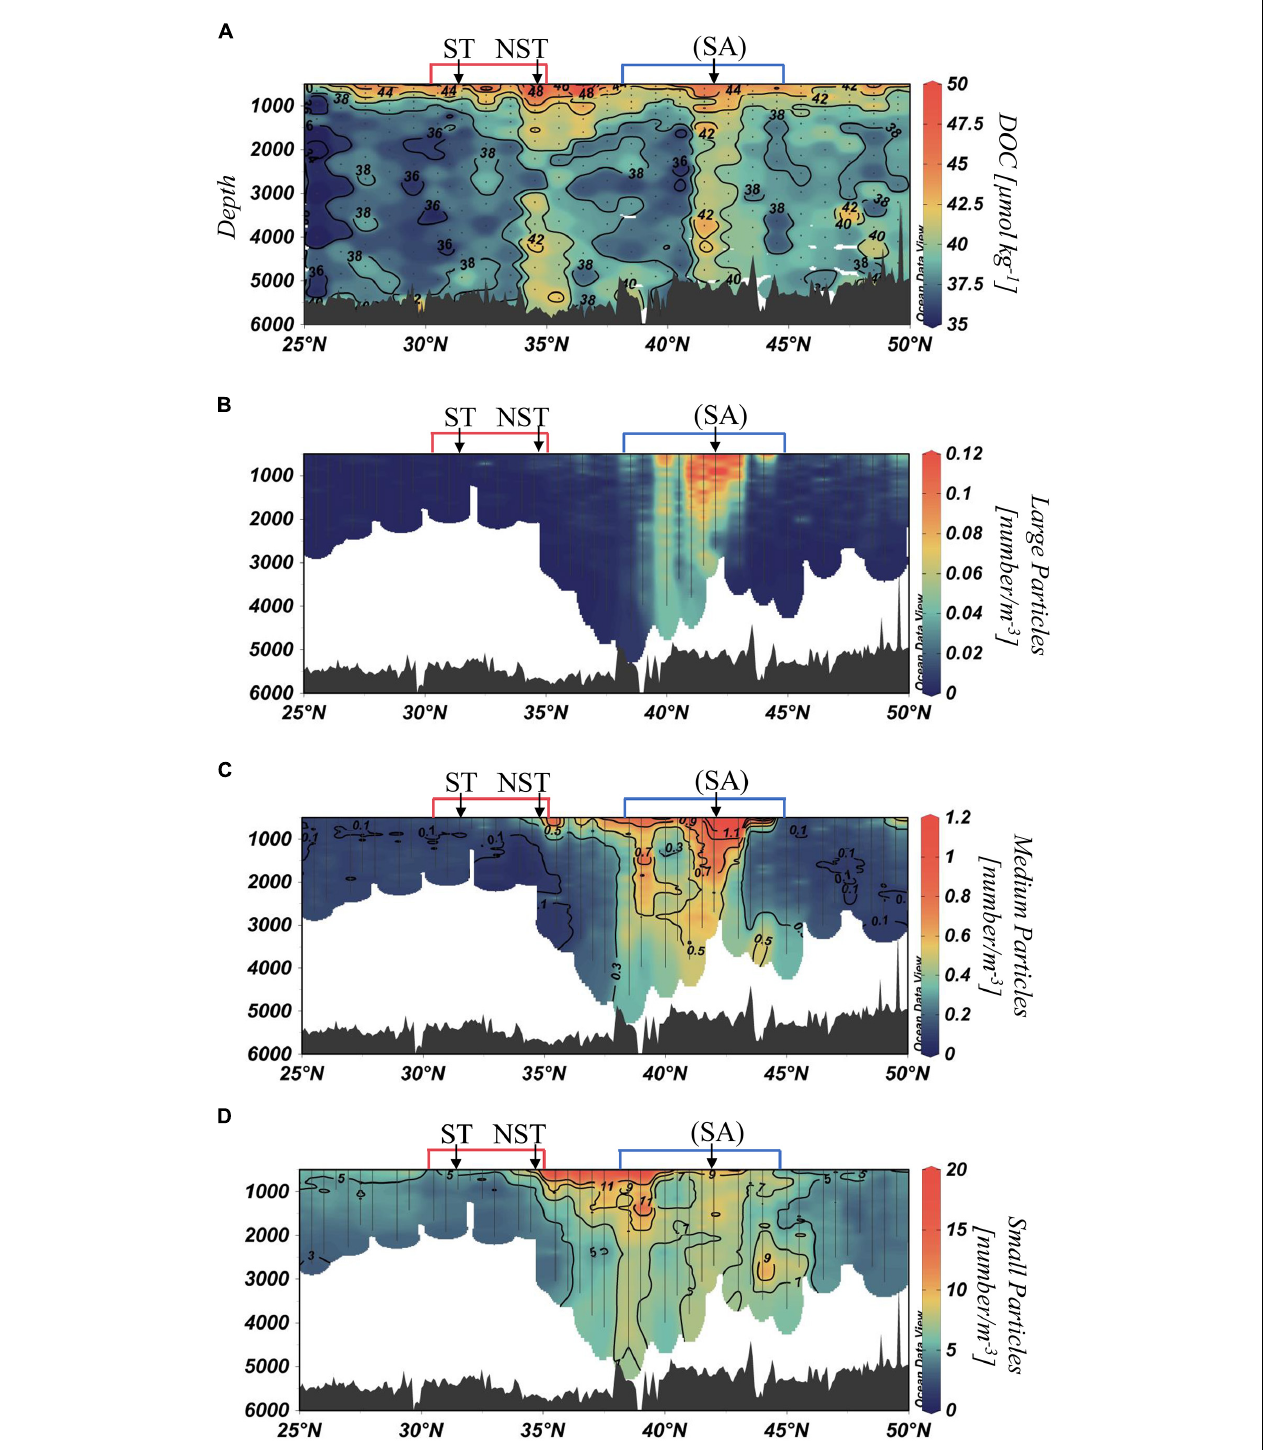
FIGURE 3 | Distributions at > 500 m along P16N in spring 2015 of dissolved organic carbon (DOC) [ µ mol kg − 1 ] (A) , large particle abundance of size > 2.05 mm [number L − 1 ] (B) , medium particle abundance of size 0.512–2.05 mm [number L − 1 ] (C) , small particle abundance of size 0.128–0.512 mm [number L − 1 ] (D) . The locations of previously described fronts are denoted above each distribution. Red and blue bars indicate locations of the STFZ (red) and SAFZ (blue). Vertical sample lines represent continuous data from each cast, and dots represent discrete samples. Underwater Vision Profiler (UVP) data have previously been reported by McDonnell and Turner (2016) and Pretty